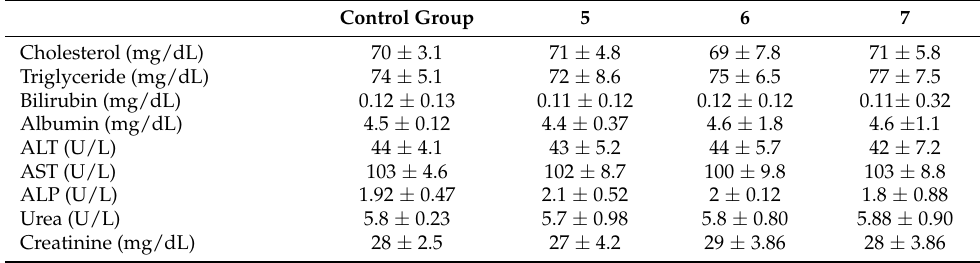
Table 1. Measurement of the change in the hepatic and renal biochemical parameters in rats treated with the investigated